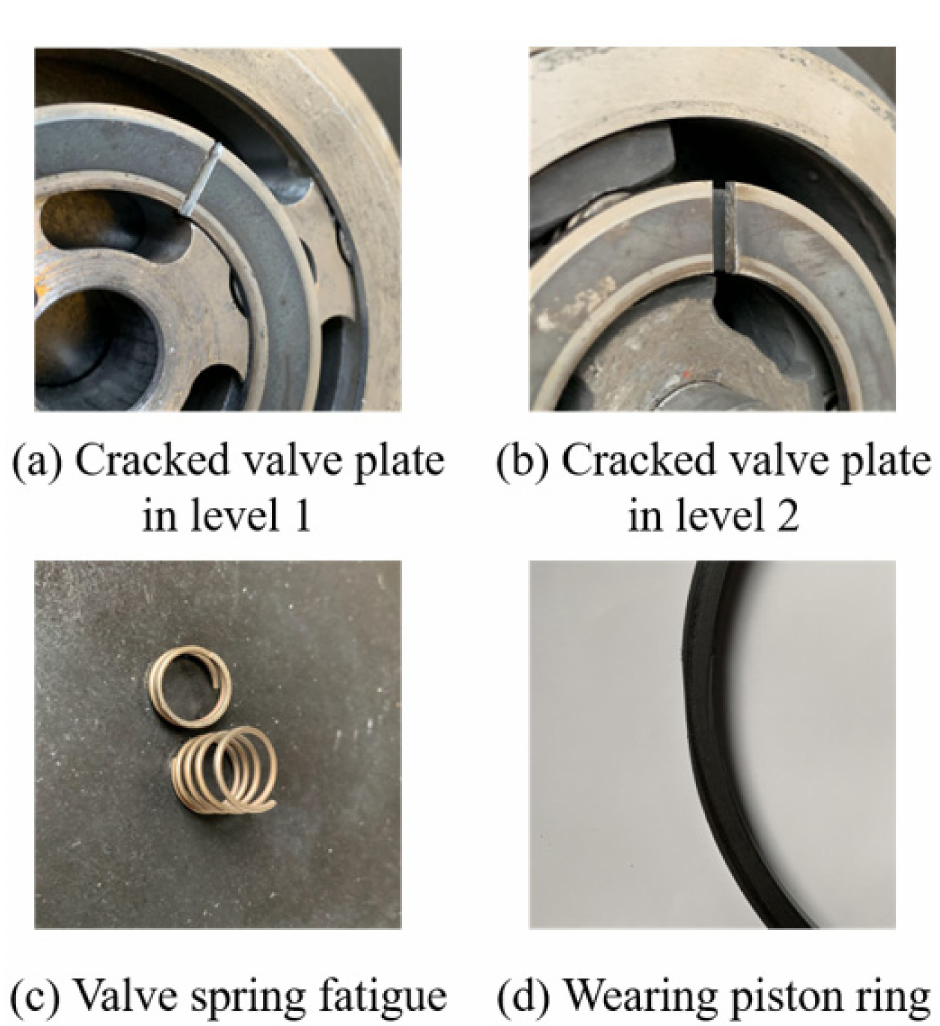
Figure 6. Faulted compressor